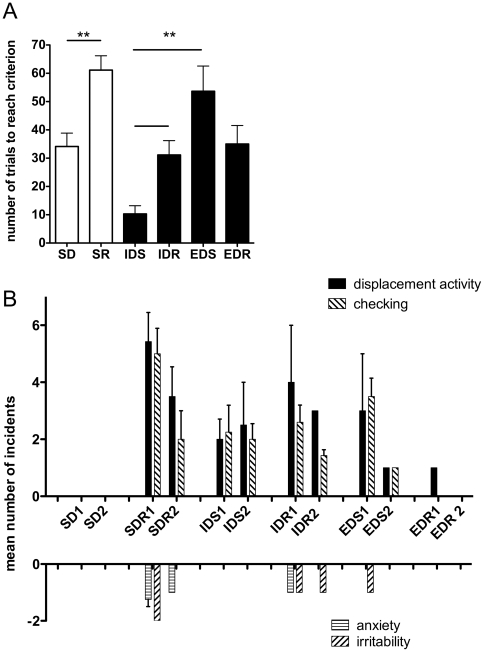
Comparison of number of trials to reach criterion in different stages of the task (A) and number of incidences of ‘emotional’ display (B).Abbreviations for different phases of the trials are described in Fig. 2.